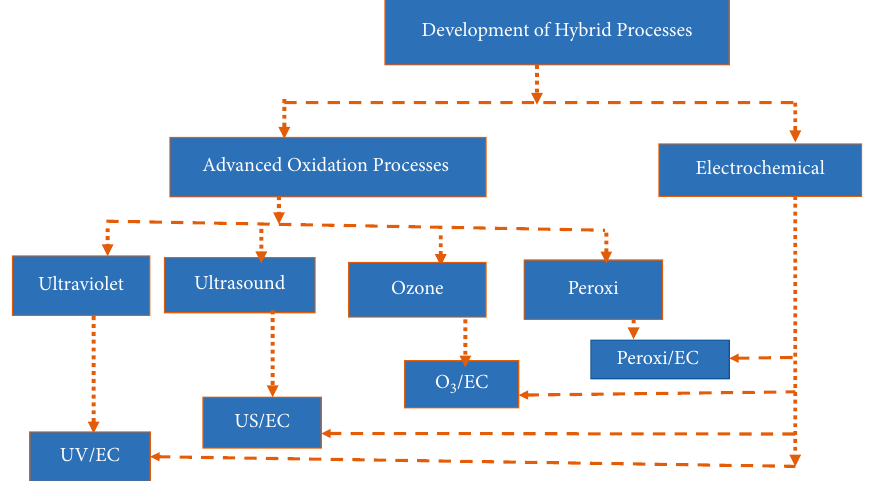
Figure 4: Development of hybrid